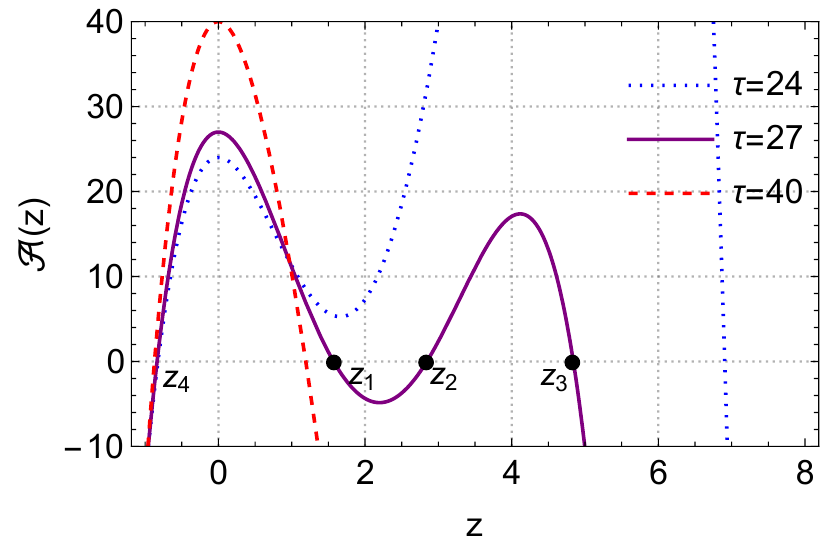
Figure 2 . Roots of the polynomial equation A ( z ) = 0 with Q = 1 , Λ = − 8 π × 0 . 0022